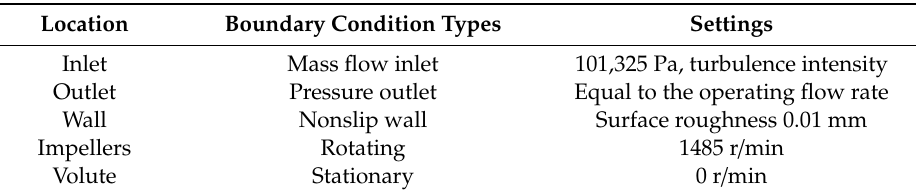
Table 5. Boundary conditions.